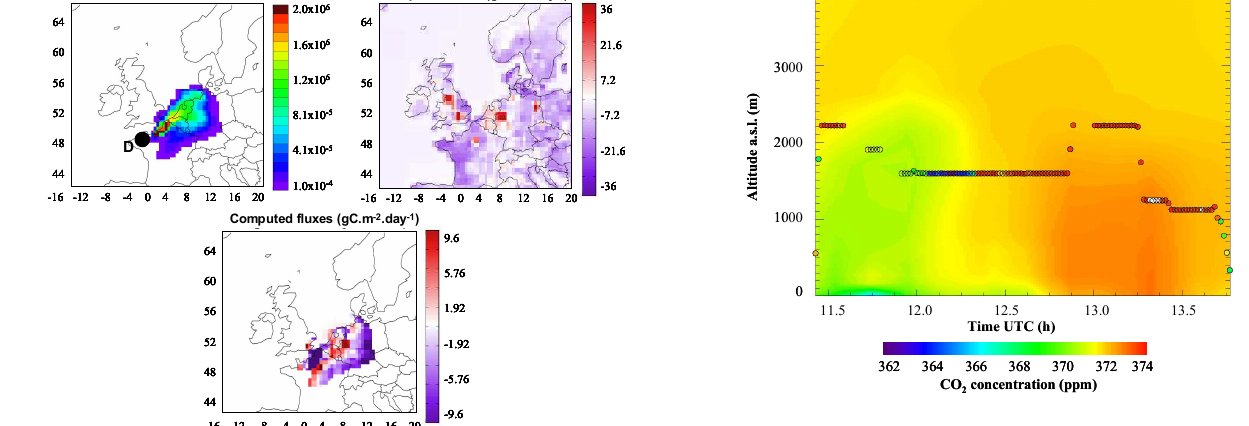
Fig. 9. Comparison of CO 2 concentration along the aircraft